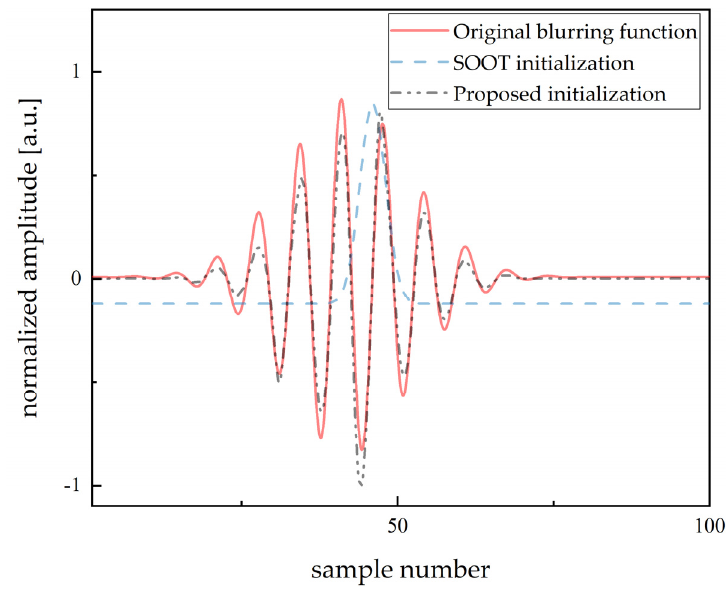
Figure 4. Comparison of initialization algorithms.